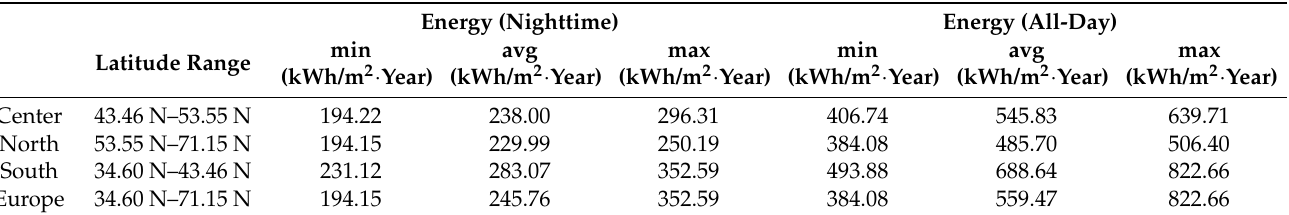
Table 2. Minimum, average and maximum annual energy potential of the different zones of Europe. Energy (Nighttime) Energy (All-Day) Latitude Range